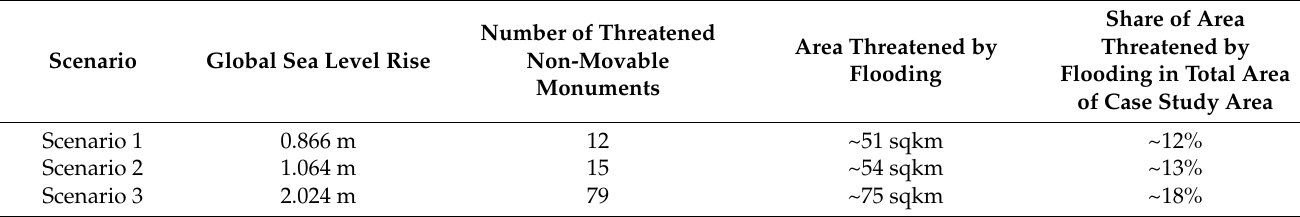
Table 6. Cultural heritage threats in Tri-City in Poland caused by Global Mean Sea Level Rise as a result of global warming. Source: own